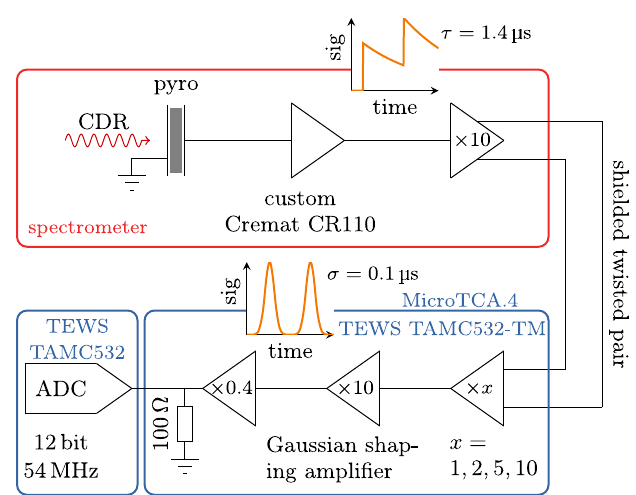
FIG. 5. Diagram of the readout electronics of one spectrometer channel. The preamplifier close to the pyroelectric detector inside the spectrometer (in vacuum) is connected via shielded- twisted-pair lines to MicroTCA.4 compliant electronic boards for Gaussian shaping amplification and analog-to-digital signal